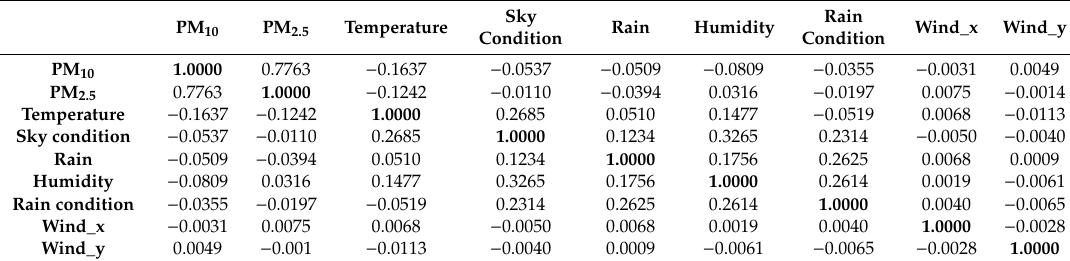
Table 2. Correlations between input factors.